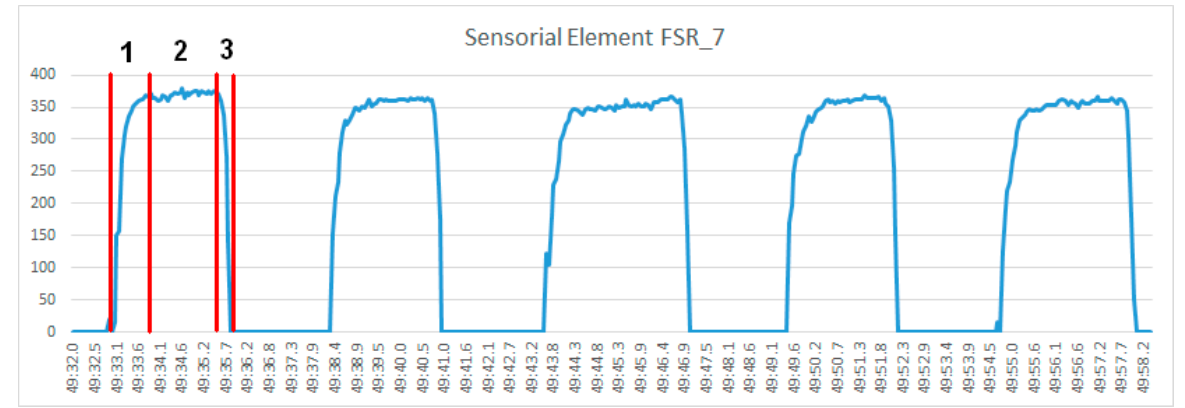
Figure 9. Sample from a repeatability dataset for FSR_7 sensor, using a 10 kg weight.